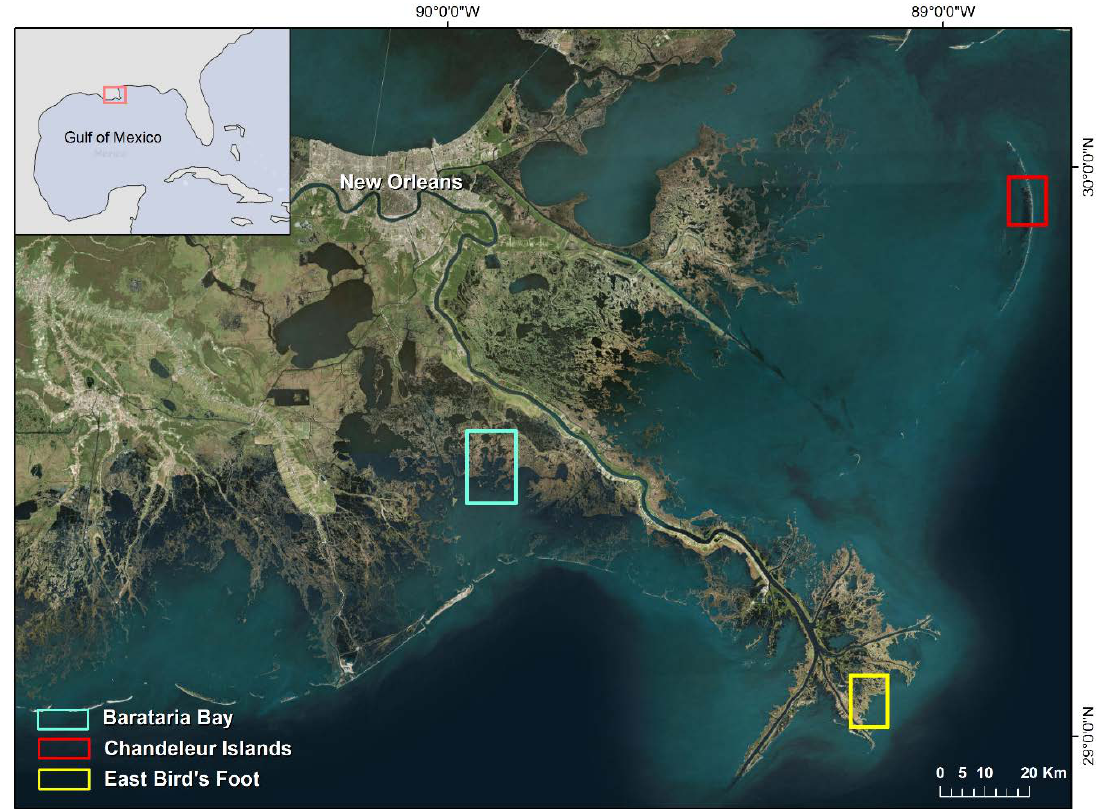
Figure 1. Location of all three study sites in the Gulf of Mexico.